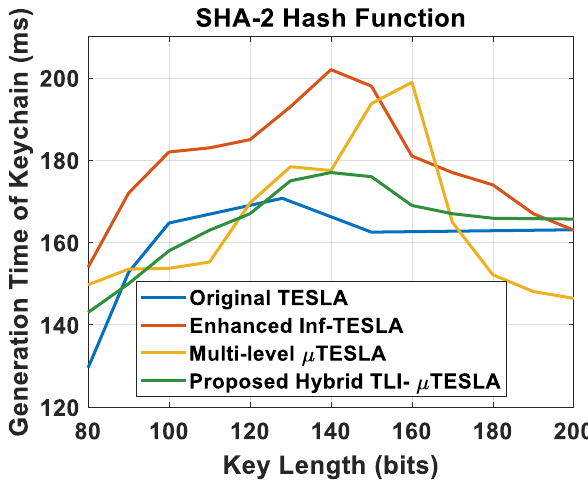
Figure 6. Simulation results of original TESLA protocol (blue line), enhanced Inf-TESLA protocol (red line), Multilevel-µTESLA protocol (yellow line), and Proposed Hybrid TLI-µTESLA protocol (green line), demonstrating the computational overhead at the sender side during the generation of a keychain with the change in the key size using SHA-2 hash function.